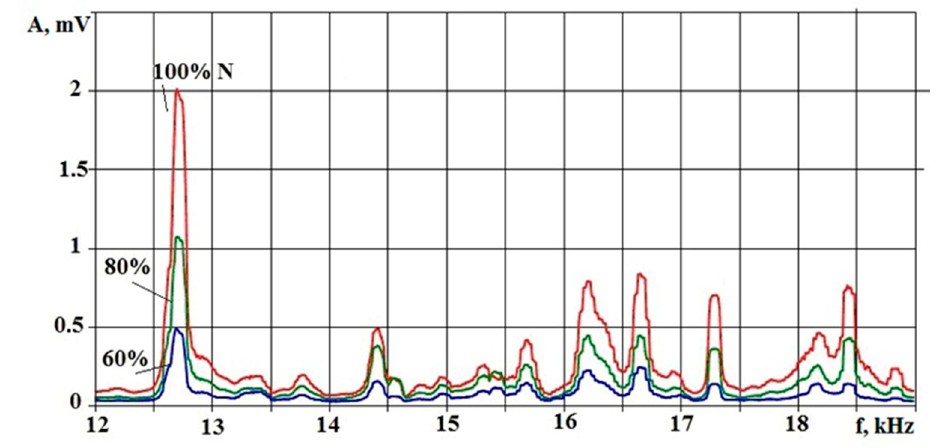
Figure 5. Vibroacoustic signal spectra at different laser radiation power outputs.